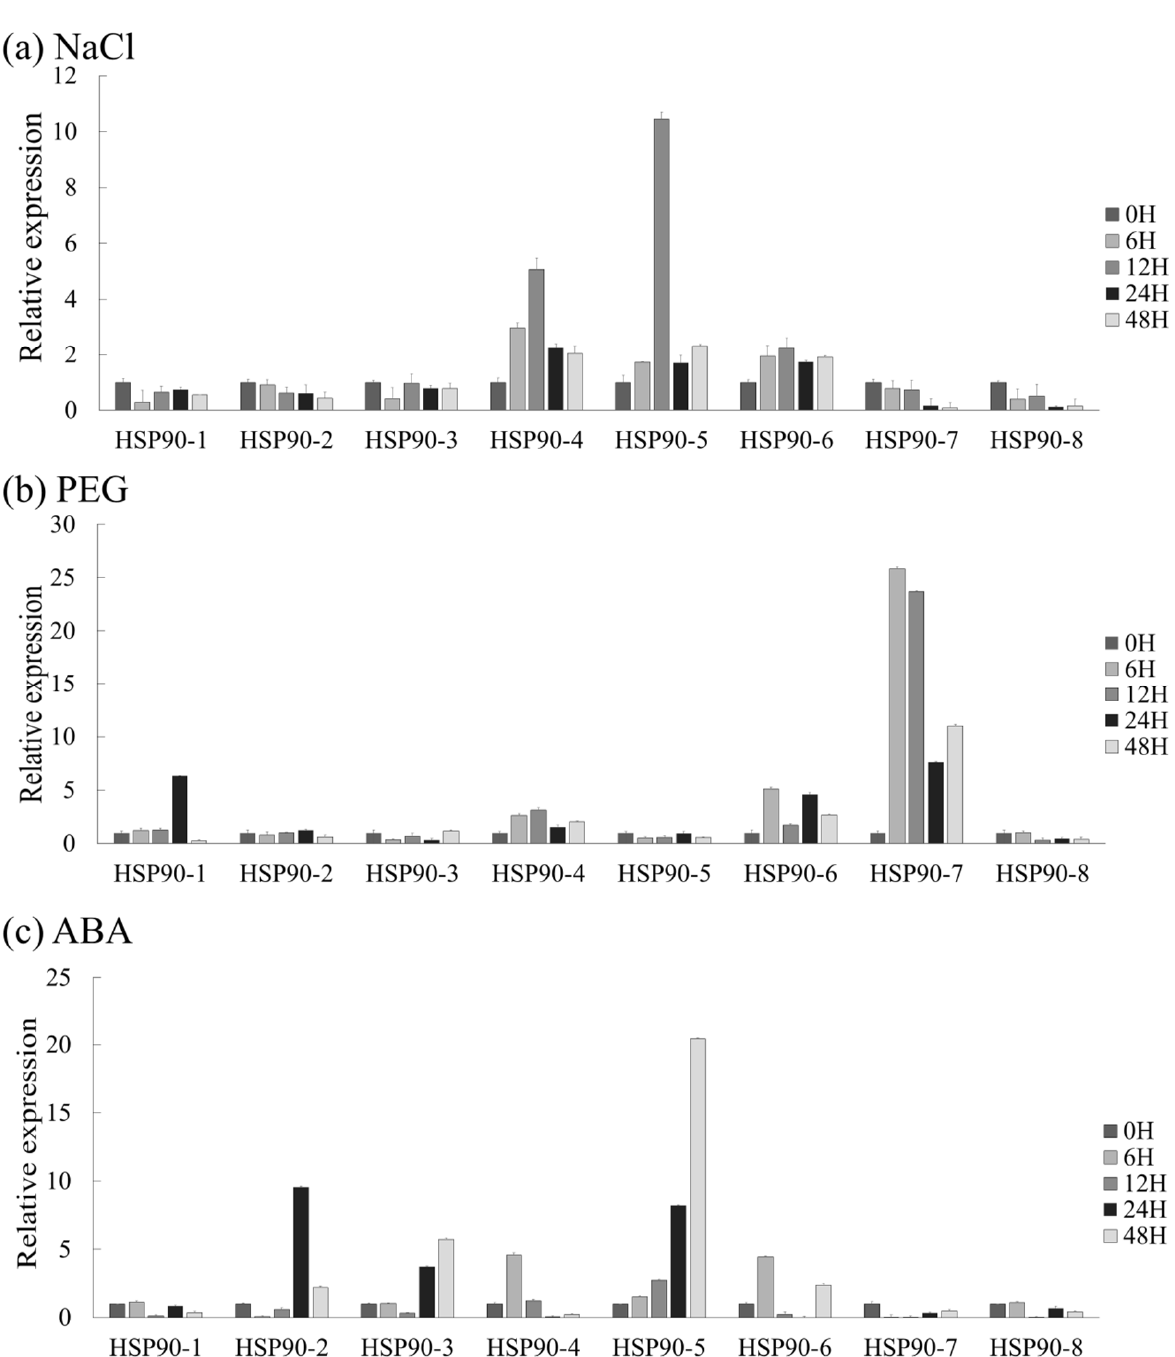
Figure 4. Expression patterns of LpHsp90s in response to ( a ) NaCl ( b ) PEG and ( c ) ABA treatment. The values are the mean values of expression (n = 3).